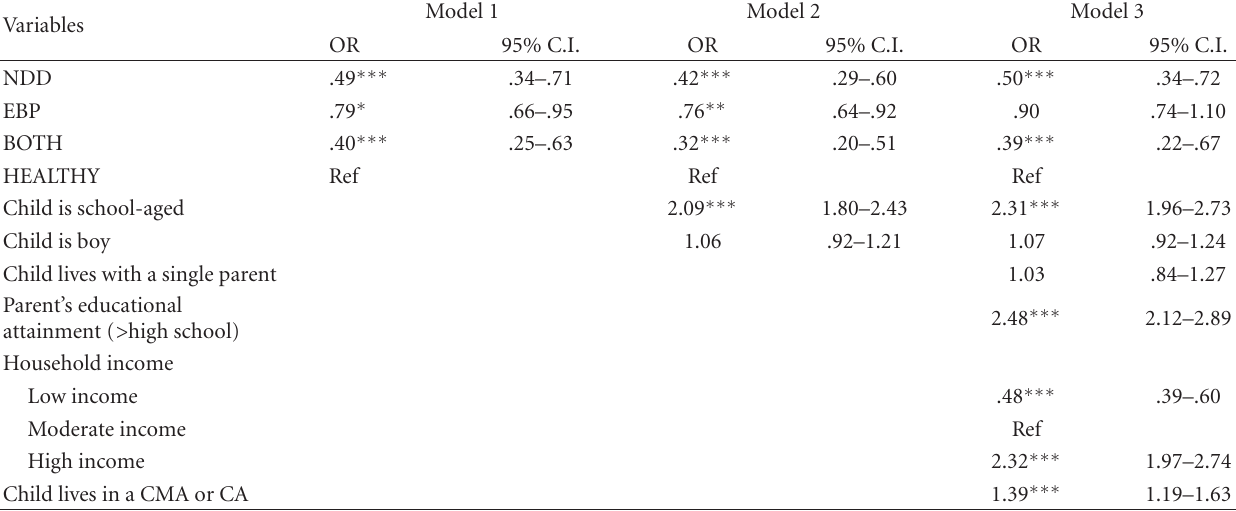
Table 2: Summary of results from logistic regression analyses predicting children’s participation in organized sports or physical activities ( N =